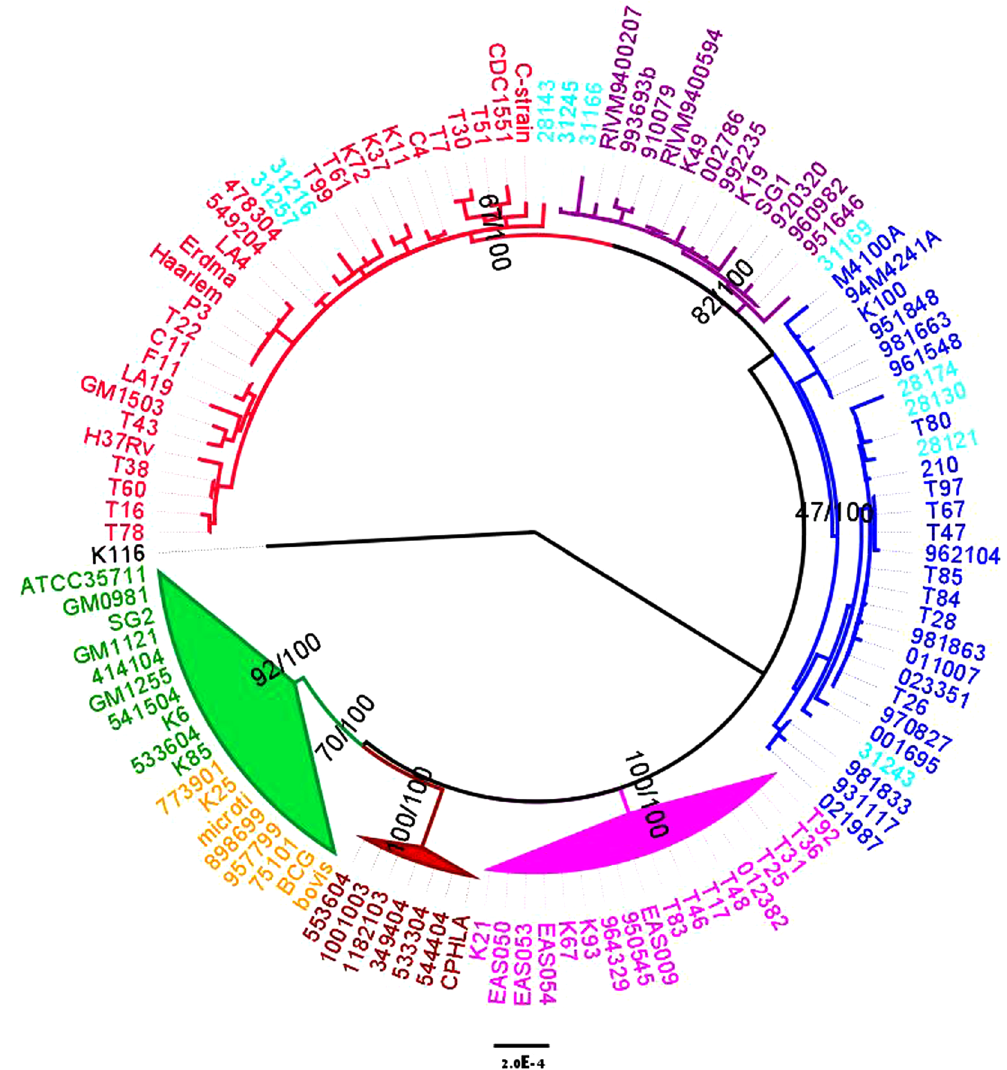
Figure 3. Multilocus sequence analysis phylogeny of M. tuberculosis complex using 82 concatenated gene sequences in 118 strains. The same topology was obtained by maximum likelihood (ML) and bayesian inference methods (BI) (see main methods for details). Values on the nodes represent clade support obtained from 1,000 bootstrap pseudo-replicates from the ML analyses and bayesian a posterior probabilities. Cyan text indicates isolates from this study. The color codes are: pink-Lineage 1, blue-Lineage 2, purple-Lineage 3, red-Lineage 4, brown-Lineage 5, green-Lineage 6 (involving the Animal Strains). The scale bar indicates the average number of nucleotide substitutions per site.